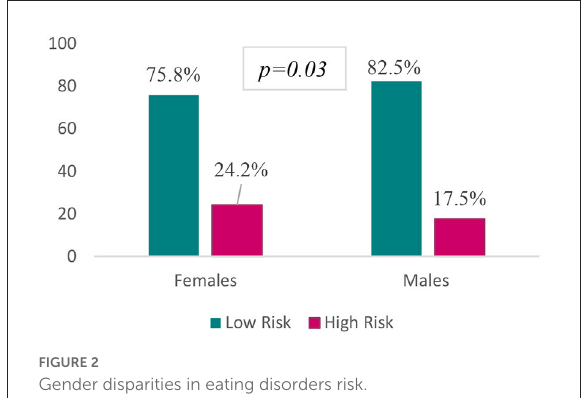
FIGURE2 Gender disparities in eating disorders